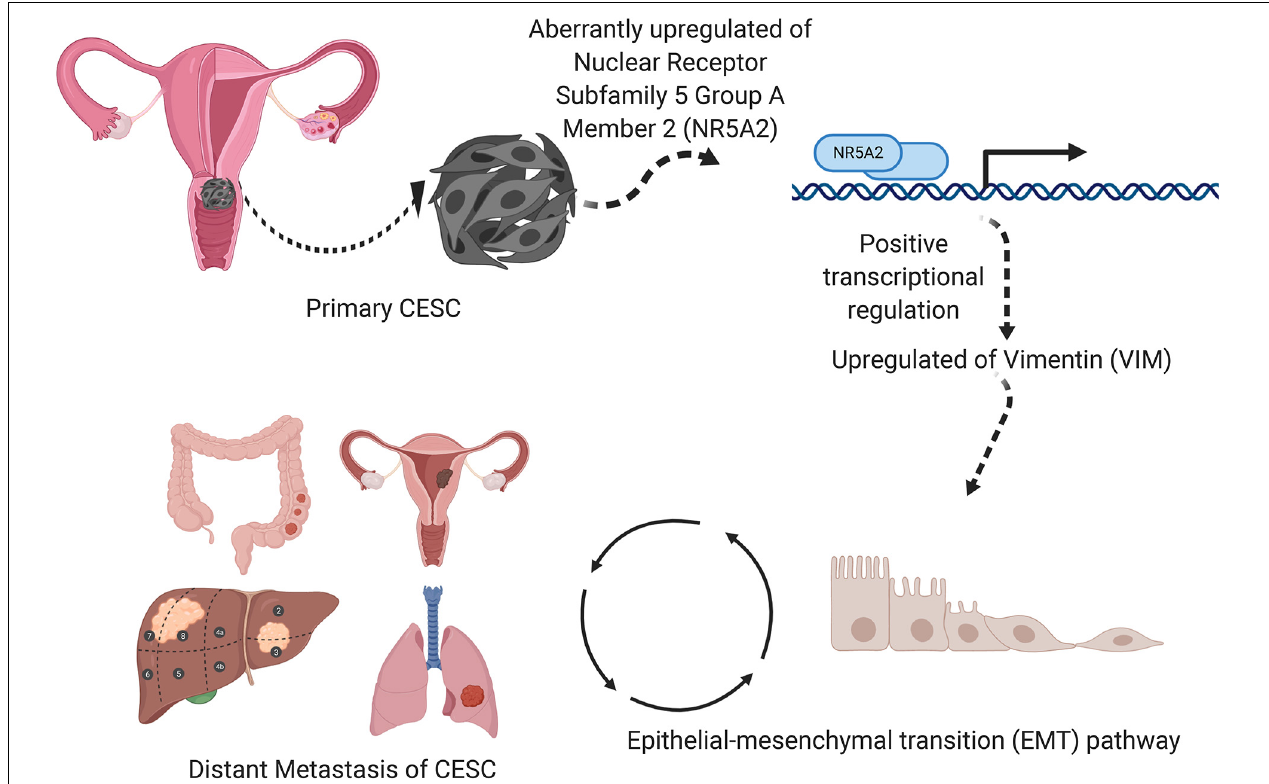
FIGURE 11 | A speculatively schematic diagram of the scientific hypothesis including the most significant DESRG (VIM), TF (NR5A2), and downstream pathway (Hallmark epithelial mesenchymal